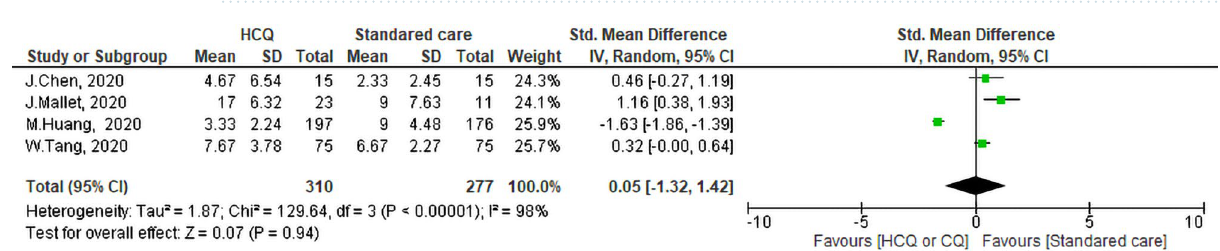
Figure 9. Need for mechanical ventilation of the Hydroxychloroquine ± Azithromycin versus standard care.